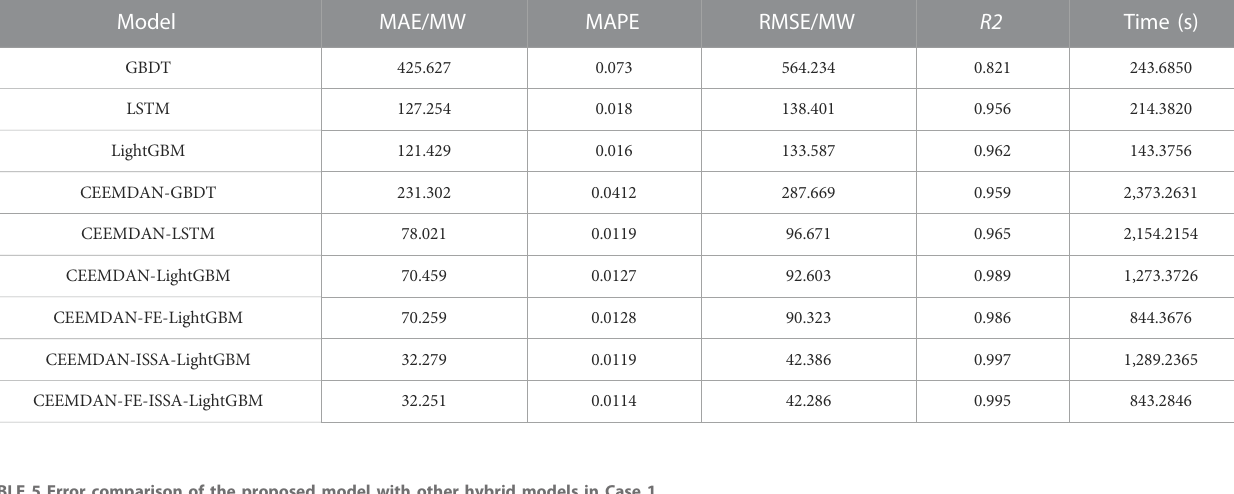
TABLE 5 Error comparison of the proposed model with other hybrid models in Case 1.